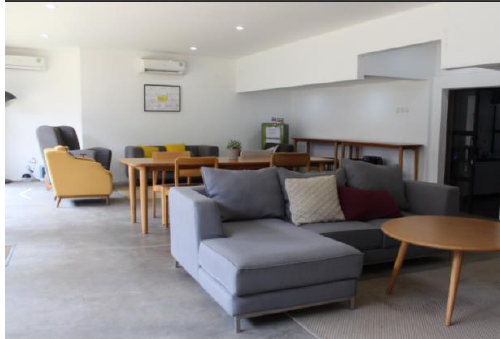
Fig. 1 Lounge in Freeware Labs Kemang (Freeware Spaces, 2015)